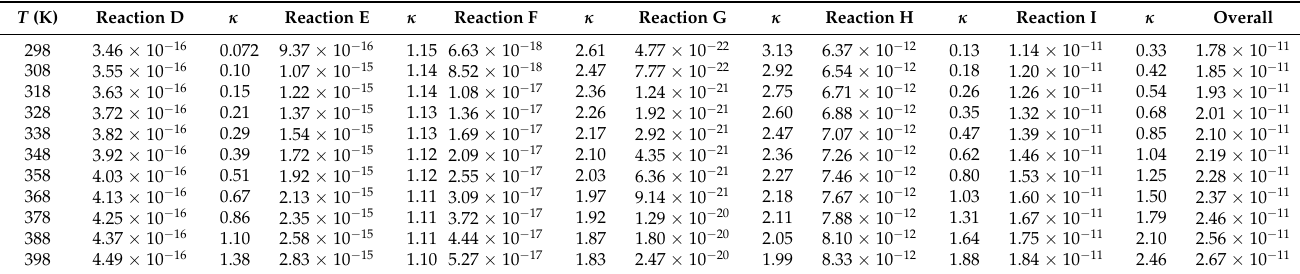
Table 2. Partial and overall rate constants (cm 3 molecule − 1 s − 1 ) and Eckart coefficients as a function of temperature of EB-Ortho reaction with NO 2 . T (K) Reaction